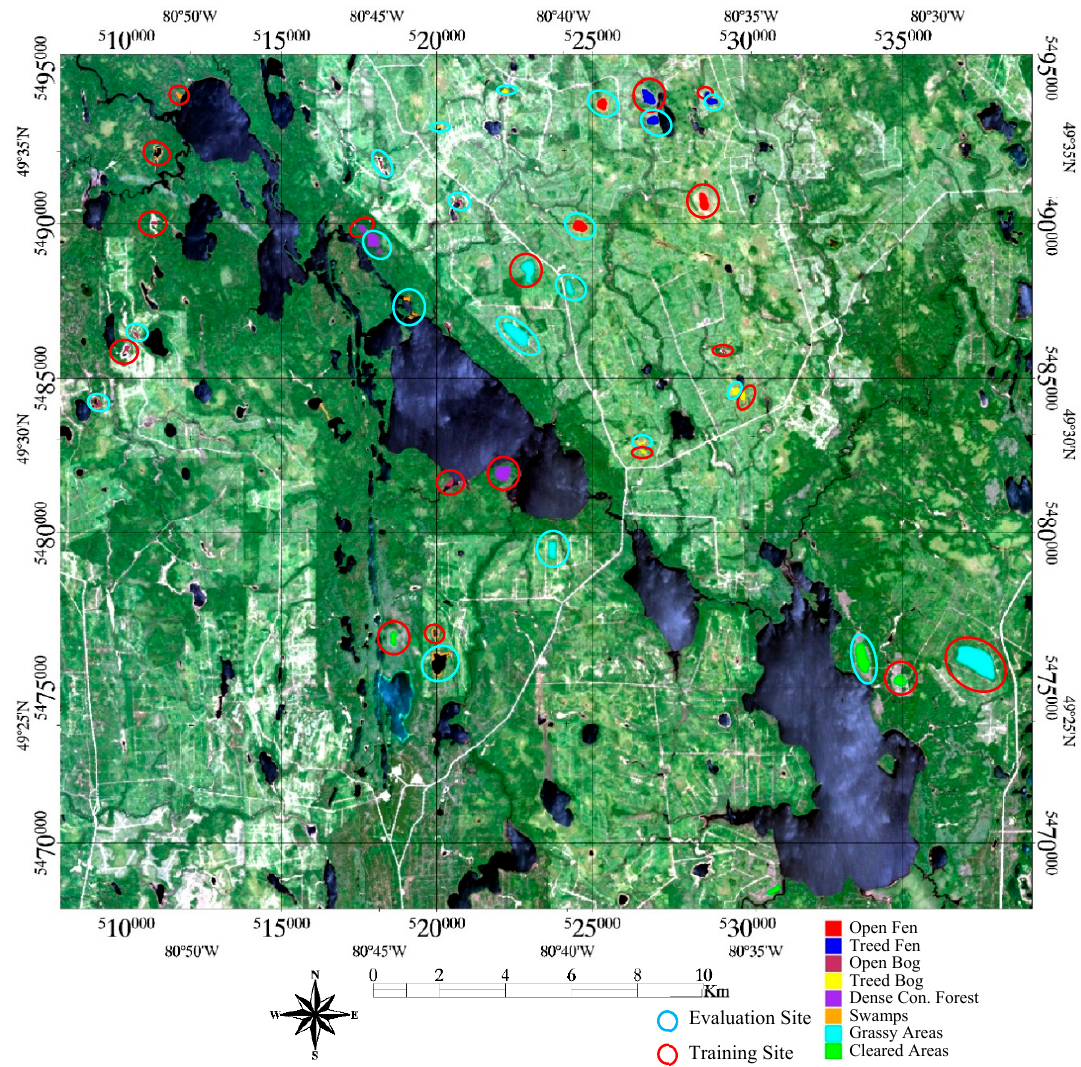
Figure 2. True color Landsat-5 image of study area with training (red circles) and evaluation (light blue circles) highlighted for individual land covers.